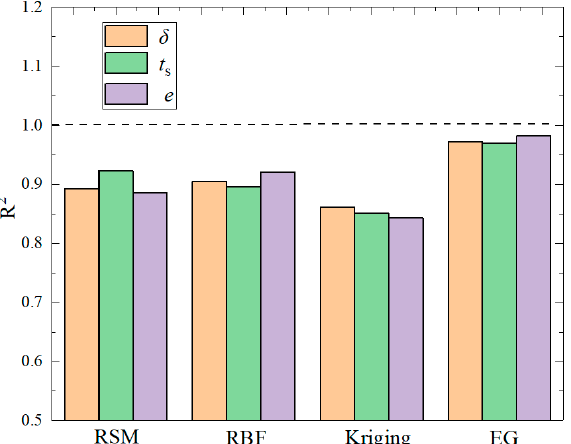
Figure 19. Coefficient of certainty R 2 for each output response for different surrogate models.